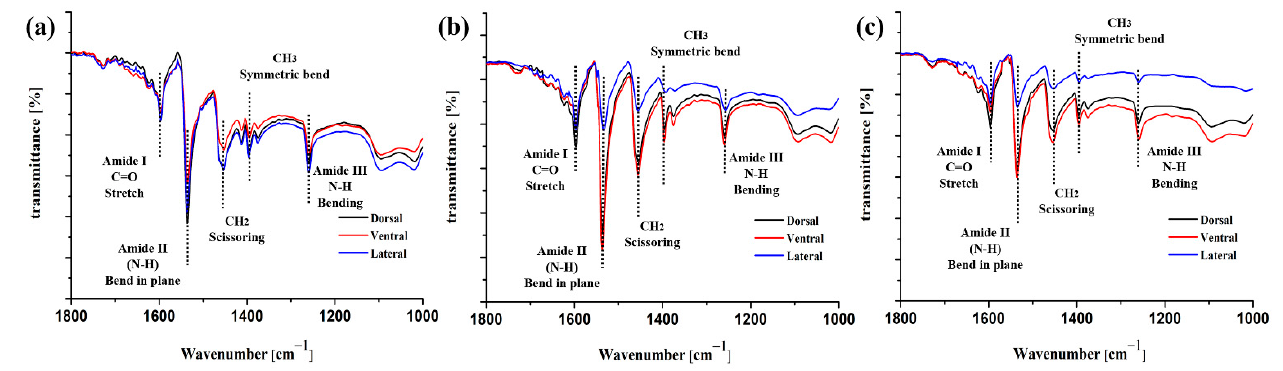
Figure 2. Infrared spectrum of the ( a ) calamus, ( b ) middle and ( c ) distal shaft.